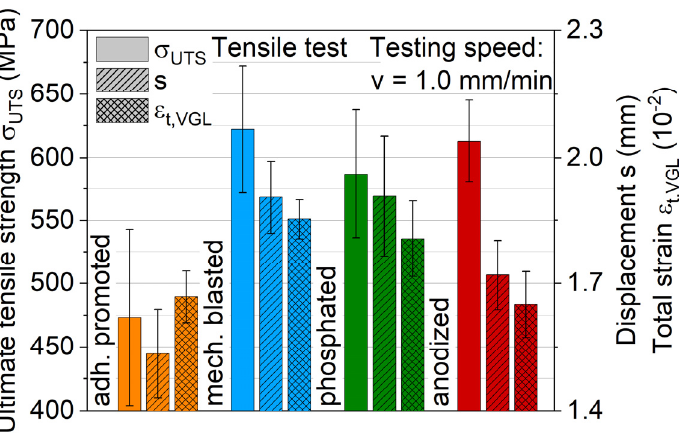
Figure 8. Arithmetic tensile strength and strain values for hybrid laminates with surface-treated aluminum alloy AA6082-T4 and a graded structure of glass and carbon fiber-reinforced PA 6 in a 2/1 configuration.